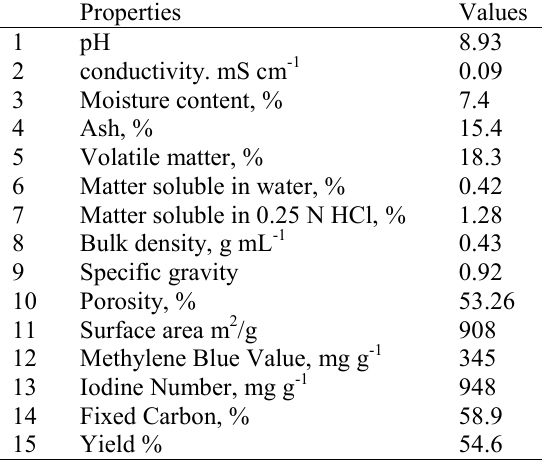
Table 1. Physicochemical characteristics of ACC.